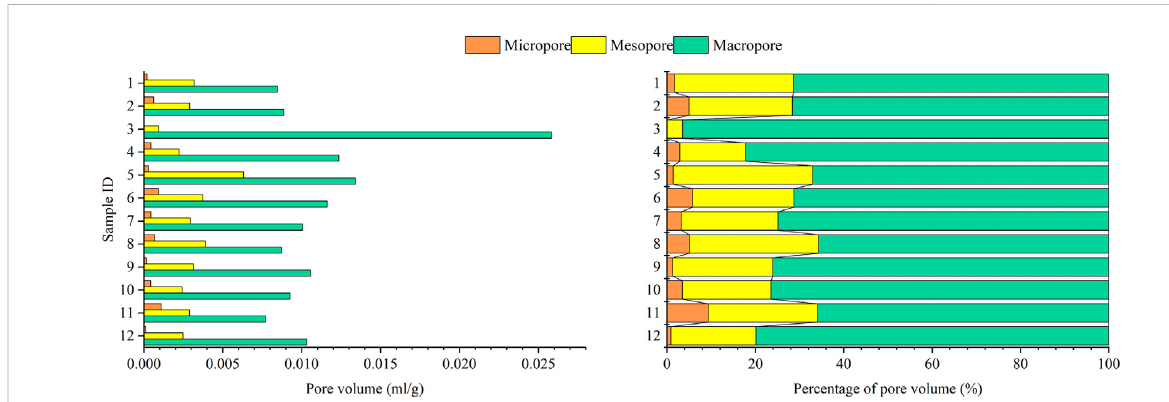
FIGURE 11 Pore volume and percentage of pore volume distributions based on IUPAC pore classi fi cation.